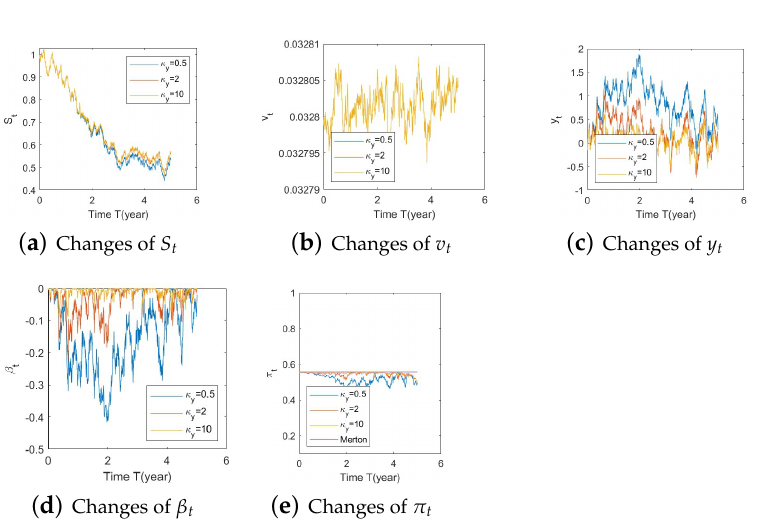
Figure A3. Illustrate the impact on ( a ) stock prices, ( b ) driver of elasticity, ( c ) elasticity of volatility, and ( d ) optimal stock allocations when varying σ y ( e . g ., σ y = 0.1,1,5 ) . 2.